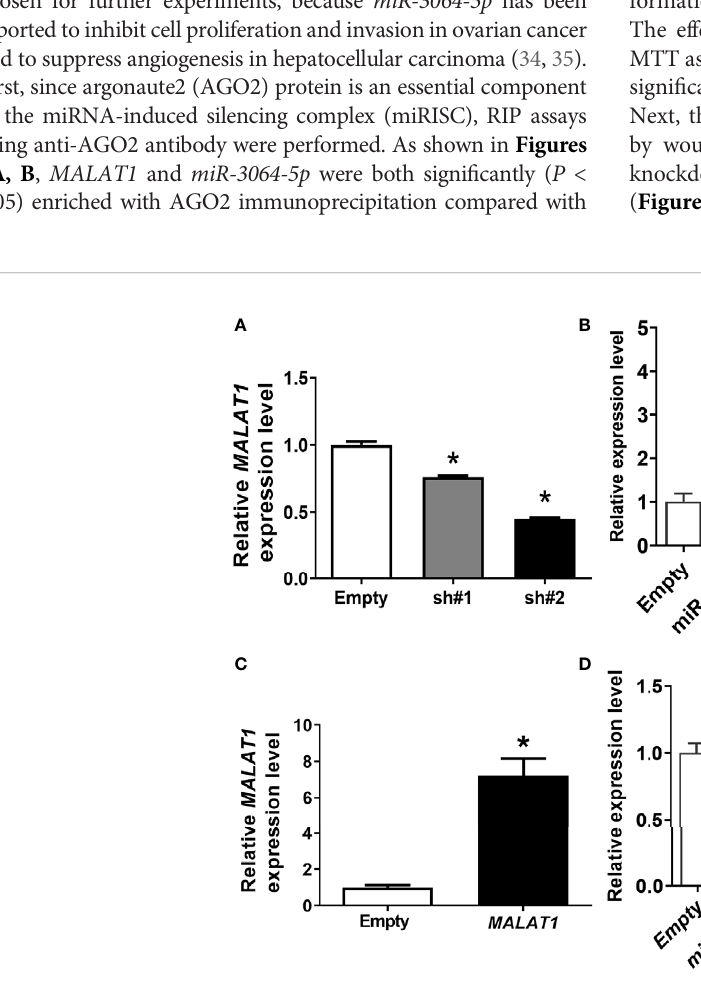
FIGURE 4 | The inverse relationship between expression levels of miRNAs and MALAT1 . (A) Relative expression levels of MALAT1 in MDA-MB-231 cells were reduced with shRNA against MALAT1 under hypoxia. The expression levels were measured by qPCR. Loading control: 18S rRNA. (B) Relative expression levels of miRNAs in MDA-MB-231 cells transfected with shRNA against MALAT1 . (C) Relative expression levels of MALAT1 in MCF-7 cells overexpressing MALAT1 . Cells were transfected with pCMV- MALAT1 and the expression levels were detected by qPCR. (D) Relative expression levels of miRNAs in MCF-7 cells transfected with pCMV- MALAT1 . Data shown are the means ± SDs (n=3). * P <